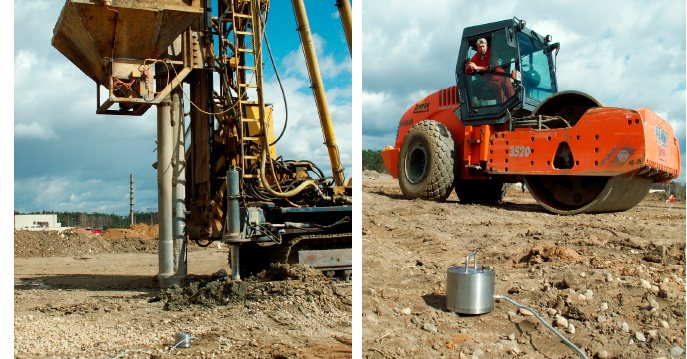
Figure 3. Example photos of measurements—vibrated gravel piles ( left ) and vibrating roller ( right ).